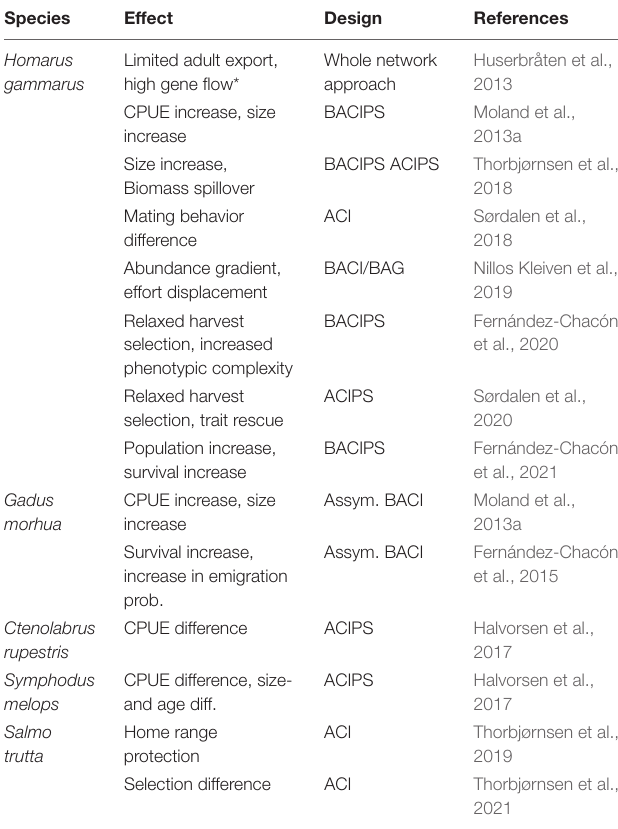
TABLE 2 | Species and MPA effects reported in the reviewed literature based on BACI-derived study designs.